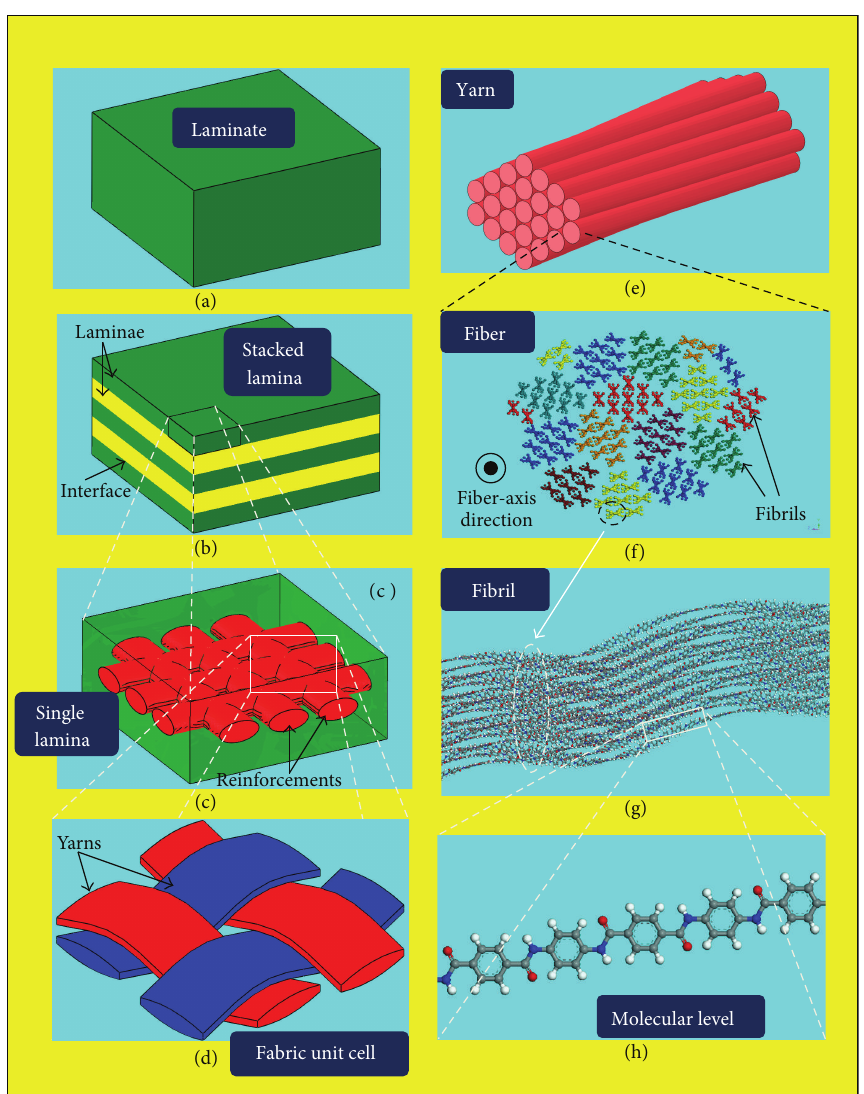
Figure 3: Microstructural hierarchy consisting of eight distinct length scales encountered in fiber-reinforced polymer-matrix composites.